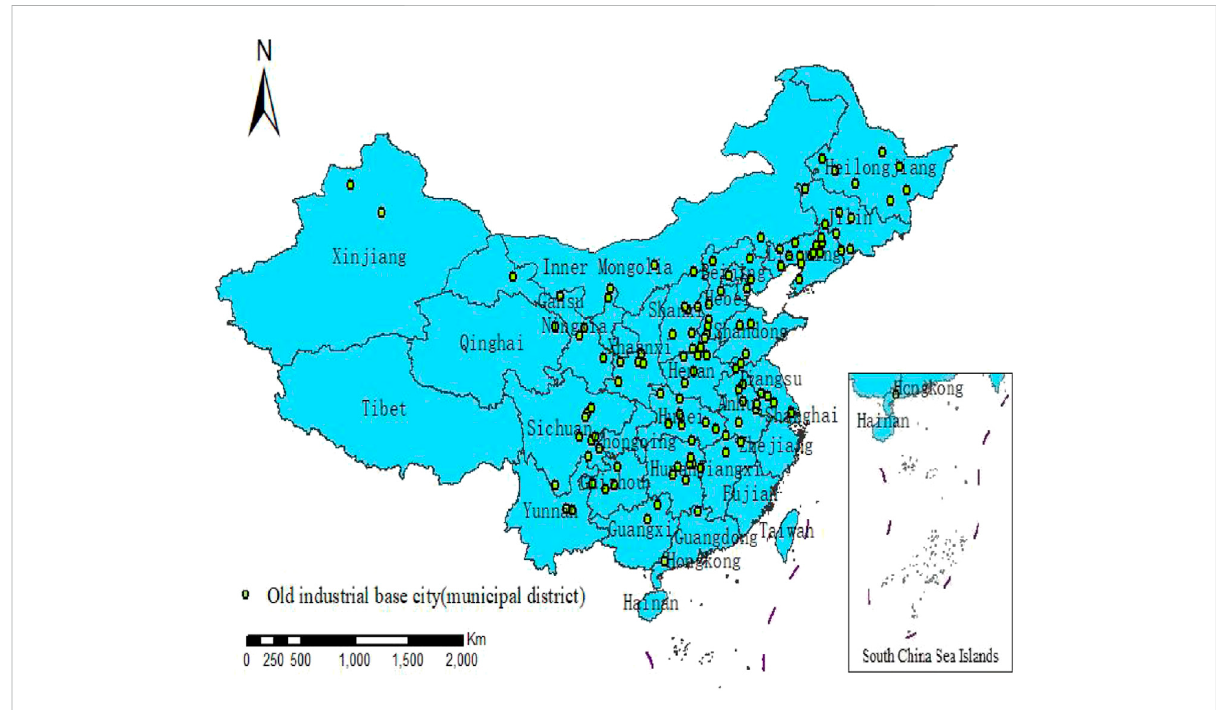
FIGURE 1 Distribution map of 120 old industrial base cities (municipal